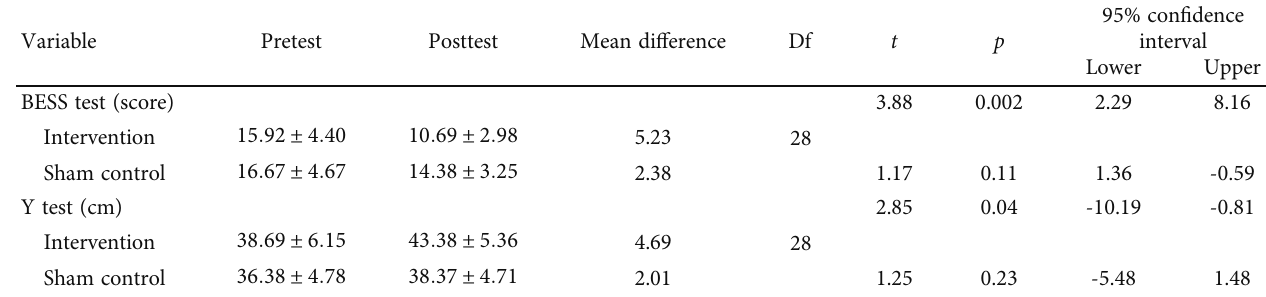
Table 4: The result of paired t